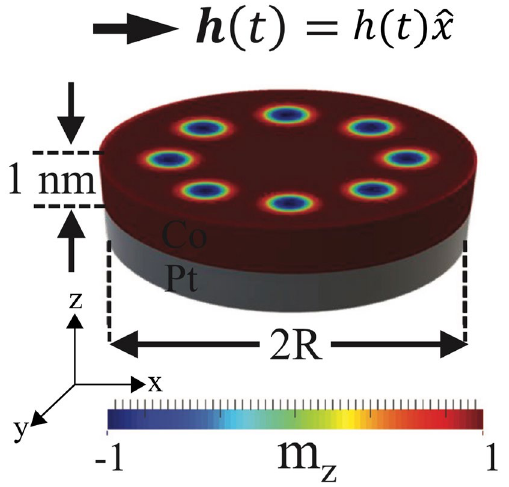
Figure 1. Schematic representation of the system